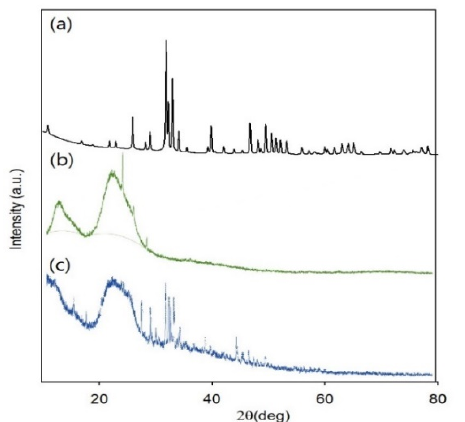
Figure 4. XRD patterns of (a) pure BGM, (b) FC/GG membrane, and (c) FC/GG-BGM membrane.